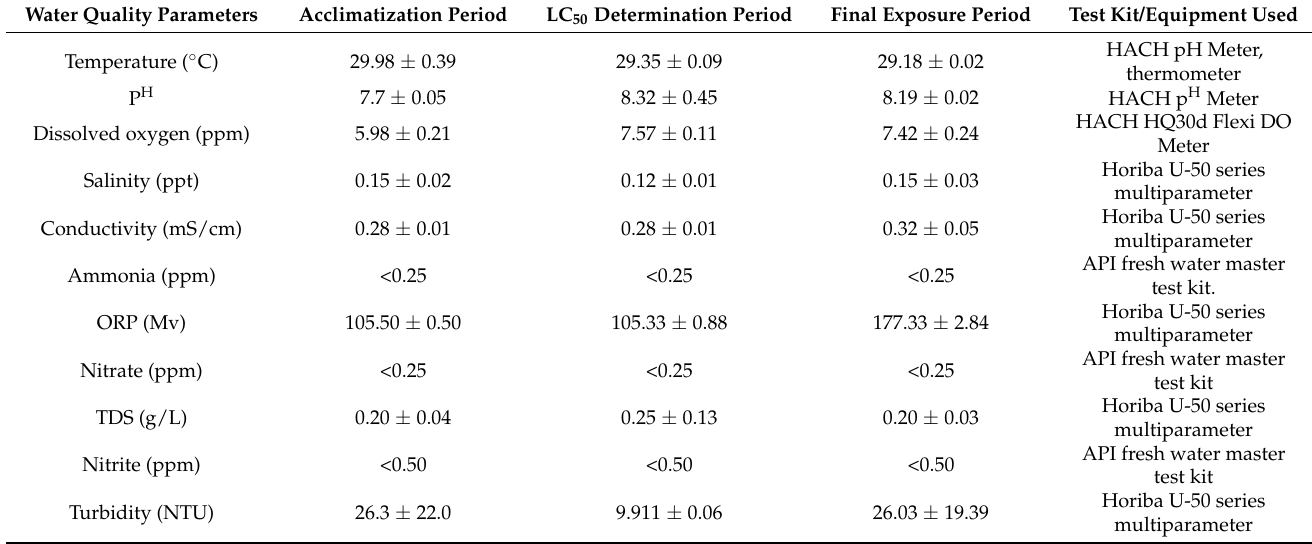
Table 2. Physicochemical properties (Mean ± Std. error) of water during acclimatization, LC 50 determination and final exposure